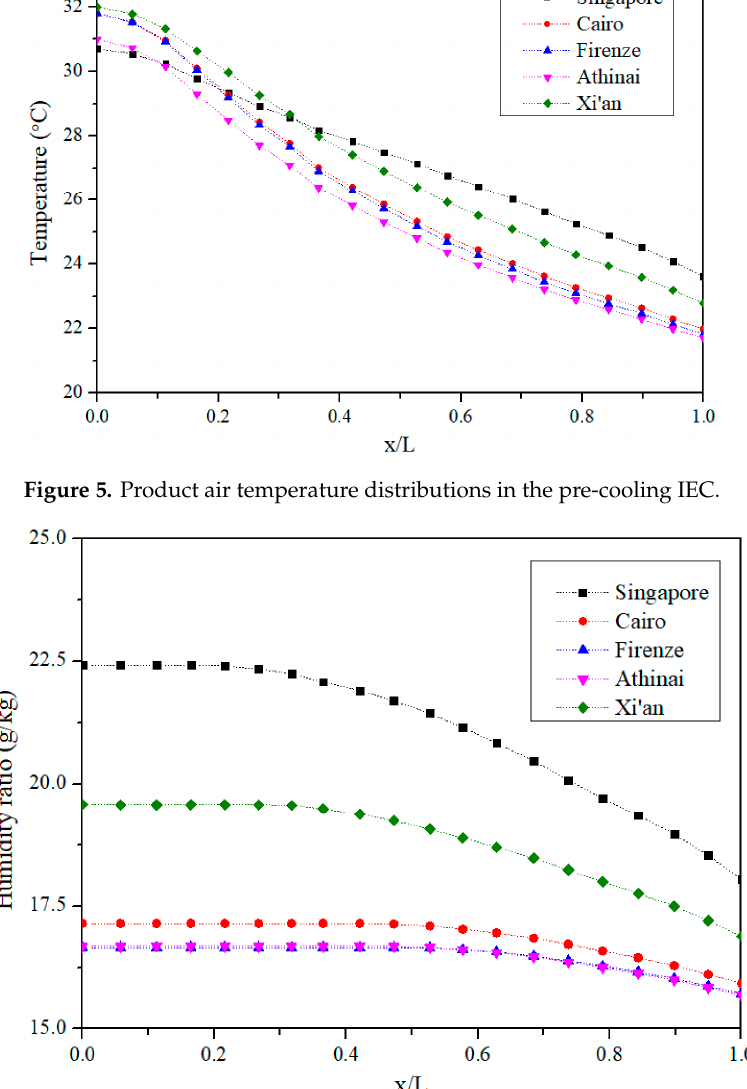
Figure 6. Product air humidity ratio distributions in the pre-cooling IEC.